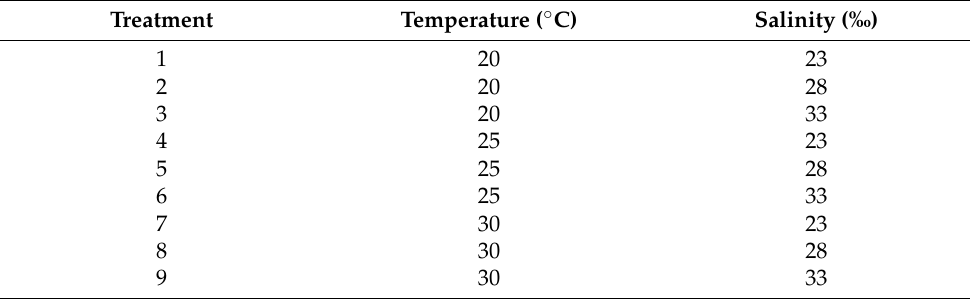
Table 1. Setup of experimental treatments for temperature and salinity. Treatment Temperature ( ◦